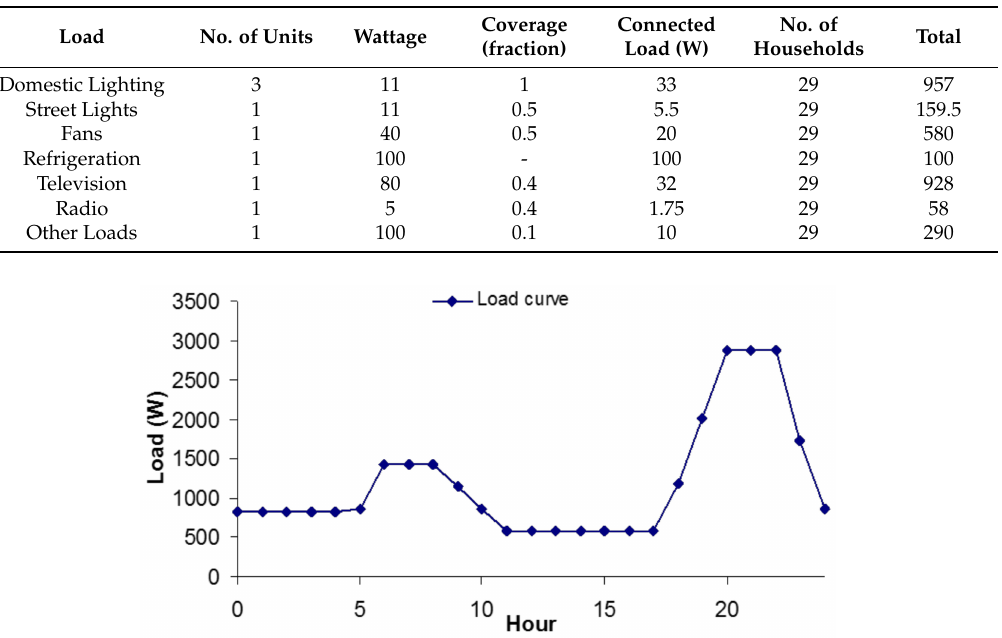
Table 2. Load data of Rajmachi village.